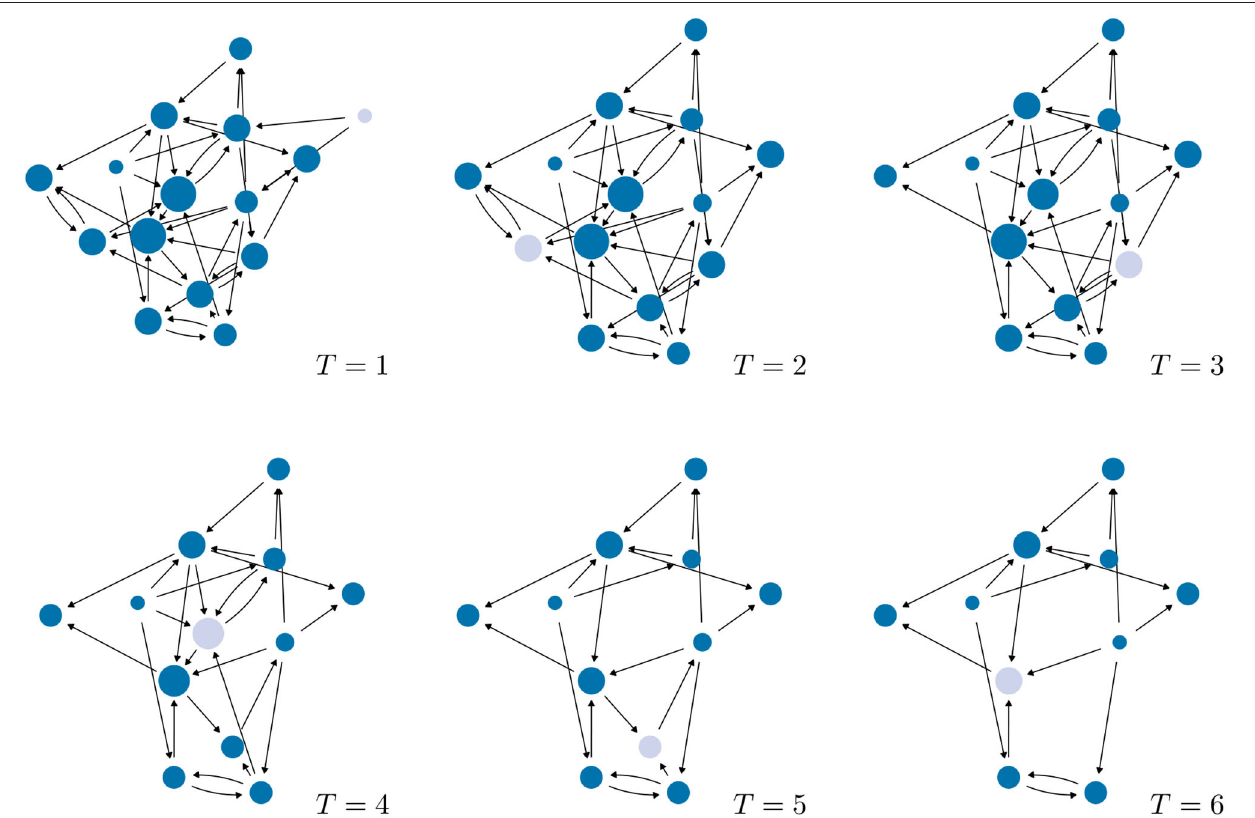
FIGURE 2 | Cascades of firms leaving a sample network of N their current in-degree. Firms colored in gray will leave the network in the next time step T . Parameters: γ